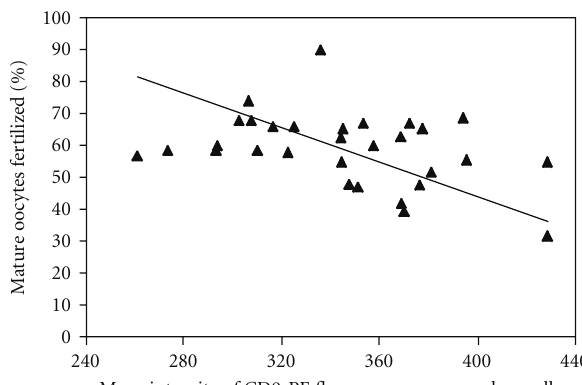
Figure 1: Flow cytometry separation of granulosa cells (GCs) from leukocytes based on intensity of staining with anti-CD45-FITC. Events showing CD45 + leukocytes are located in the upper right quadrant whereas those representing CD45 − GCs occur in the upper left. The bottom two quadrants contain a few cells that did not pick up the anti-CD9-PE antibody.